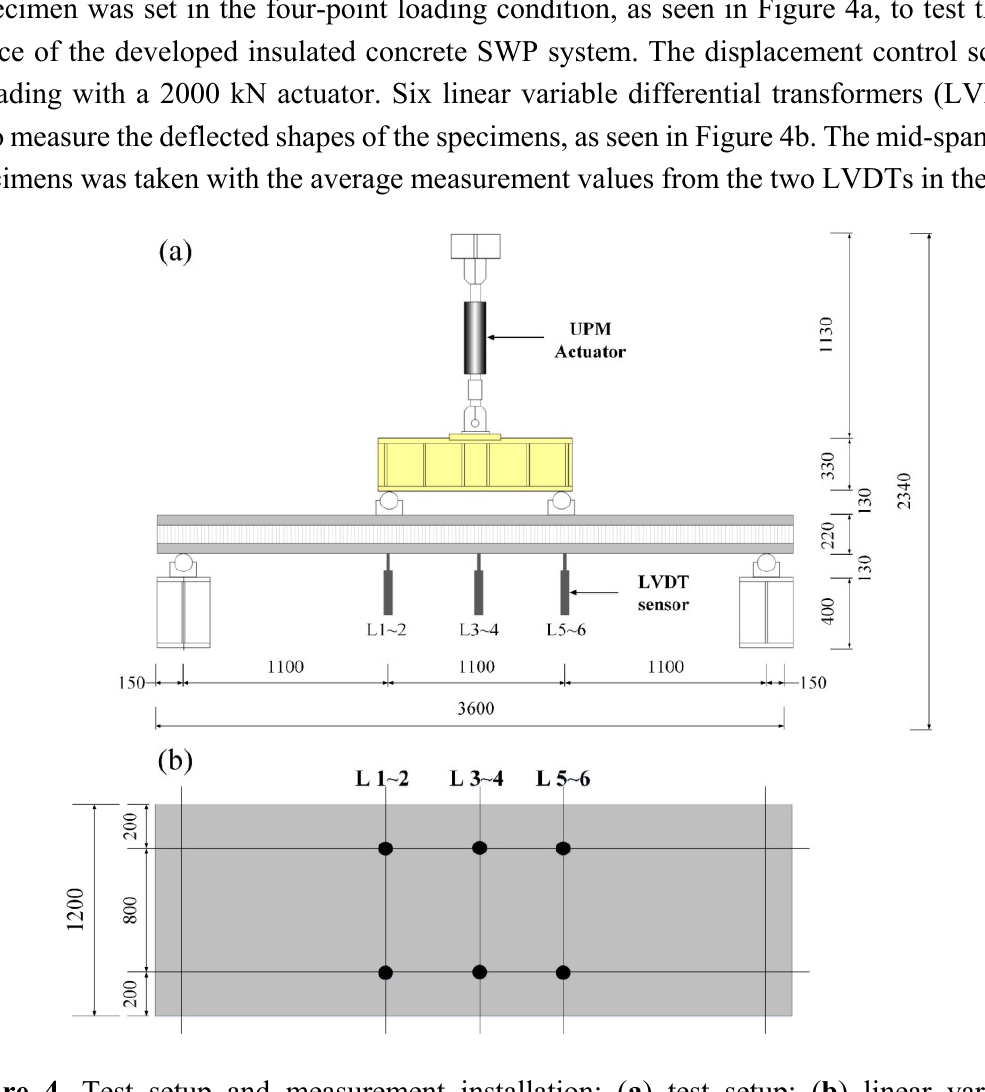
Figure 4. Test setup and measurement installation: ( a ) test setup; ( b ) linear variable differential transformers (LVDT)